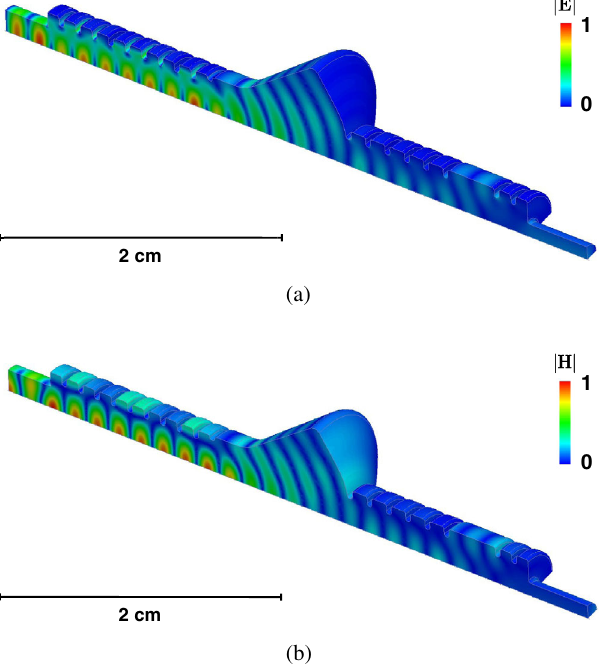
FIG. 7. Surface field profiles of the Coupling End Section, adapted from Toufexis et al. [22]. (a) Electric field and (b) magnetic field.